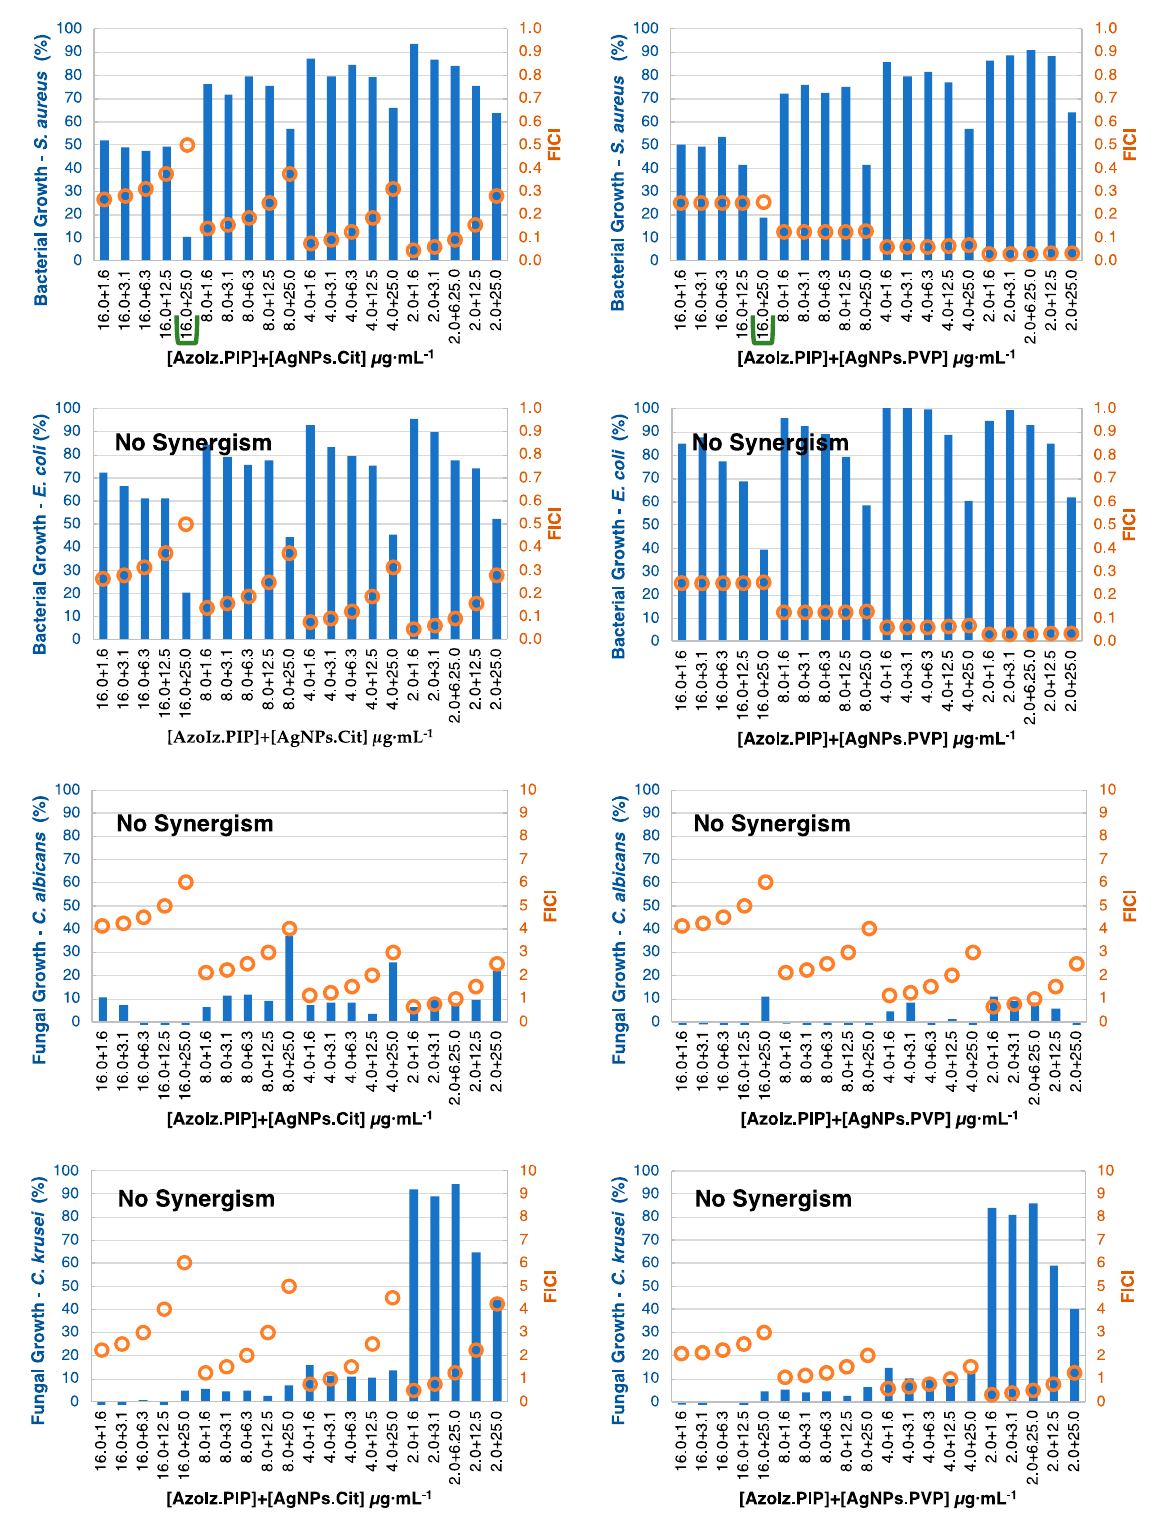
Figure 8. Checkerboard results by combining AzoIz.Pip (concentration ≤ 16.0 µ g · mL − 1 ) with AgNPs (concentration ≤ 25.0 µ g · mL − 1 ) showing positive synergistic results (green lines). Bars (blue) represent the microbial growth percentage, and dots (orange) represent the FICI values.